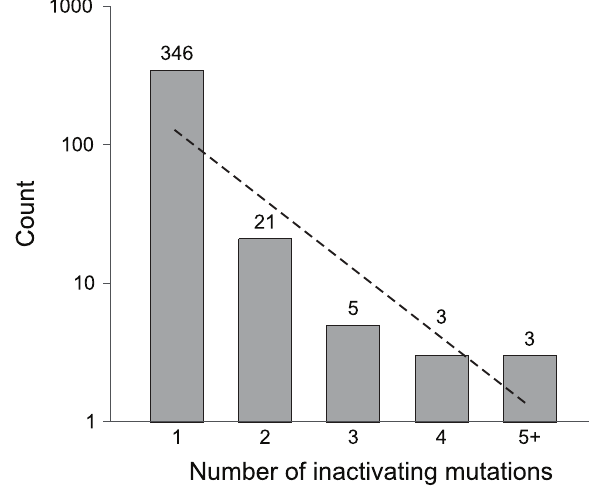
Figure 2. Pseudogenes classified by the number of gene- inactivating mutations. Numbers on top of columns indicate actual counts. The dashed line represents the neutral expectation based on an exponential regression.